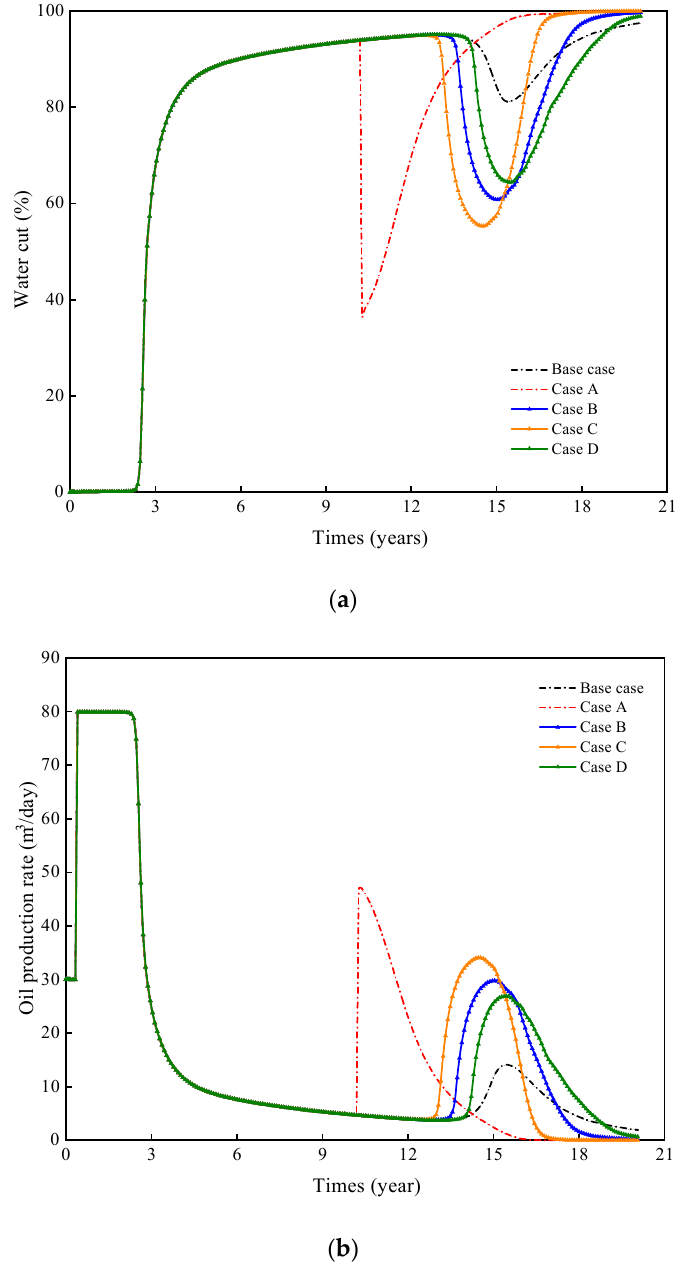
Figure 9. The effect of different polymer concentration interpolations on well performance in the case Figure 9. The e ff ect of di ff erent polymer concentration interpolations on well performance in the case study. ( a ) Water cut. ( b ) Oil production rate. study. ( a ) Water cut. ( b ) Oil production